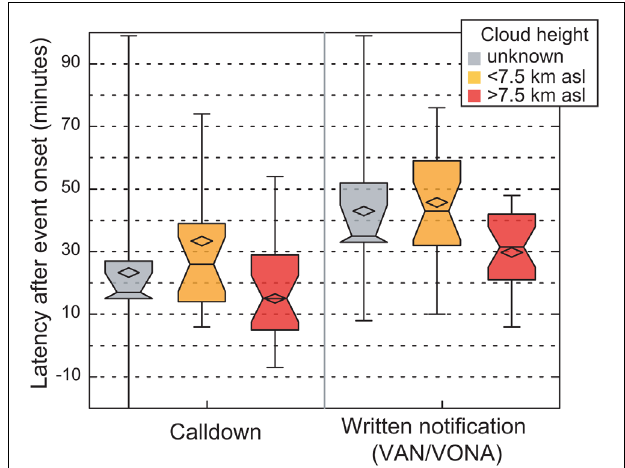
FIGURE 8 | Box-whisker plots showing times of call and VAN/VONA with respect to alarmed explosive event onset (latency). In each case, notched center shows median, bottom and top of box show 25th and 75th percentiles, and whiskers show 10th and 90th percentiles. Diamonds show means. Outliers are not shown; for full distribution, see Figure 7